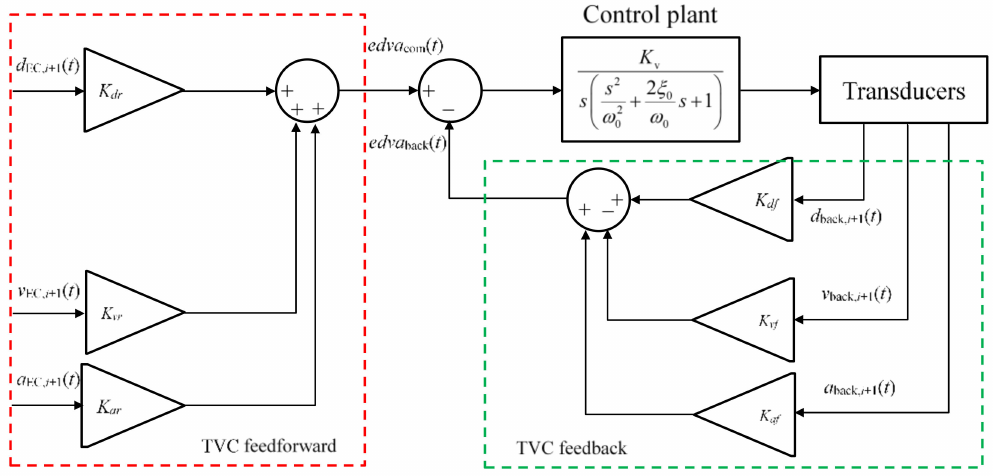
Figure 2. Shaking table substructure testing (STST) based on a three-variable control method with velocity positive feedback